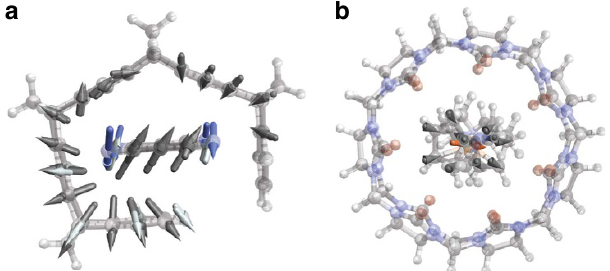
Figure 6 | The most binding fluctuation mode in two supramolecular complexes. Only atoms where the magnitude of the dipole oscillation is larger than 5% of the largest oscillation are shown. ( a ) Conjugated ‘tweezer’ complex. ( b ) Electrostatically bound cucurbituril